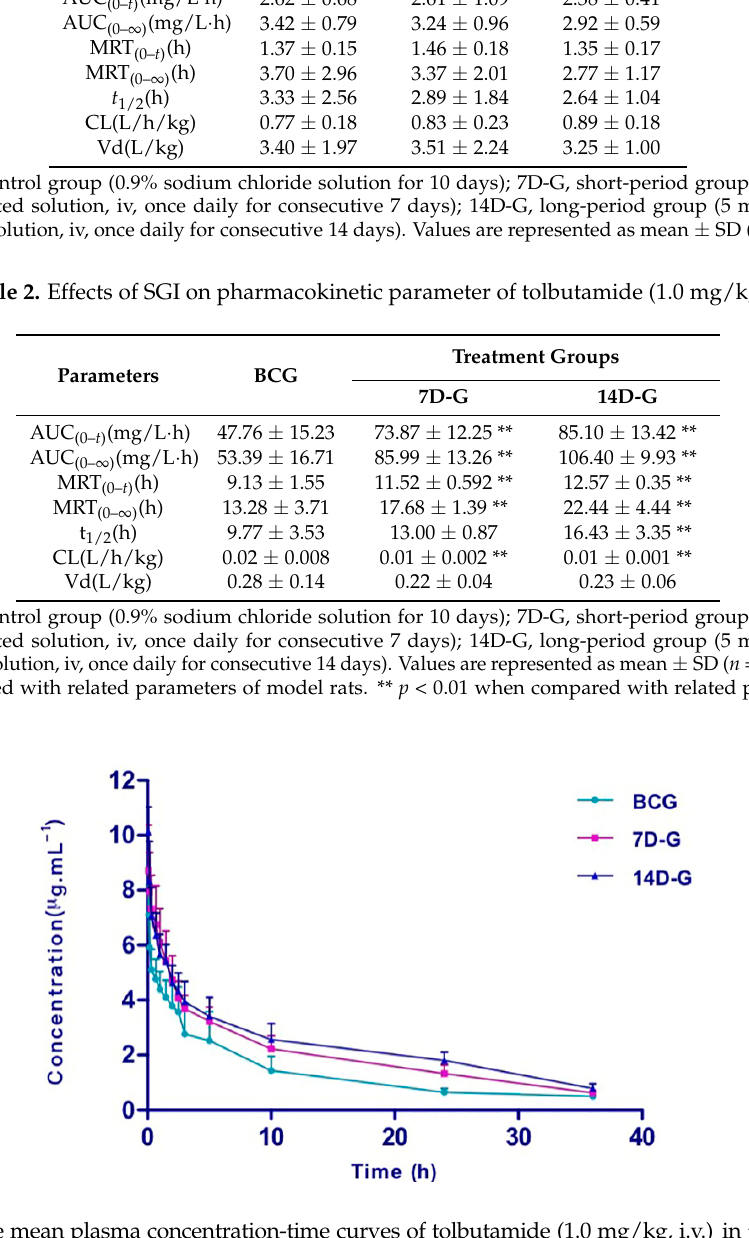
Figure 1. The mean plasma concentration-time curves of tolbutamide (1.0 mg/kg, i.v.) in the different groups ( n = 6). BCG, blank control group (0.9% sodium chloride solution for 10 days); 7D-G, short-period group (5 mL/kg of SGI concentrated solution, i.v., once daily for consecutive 7 days); 14D-G, long-period group (5 mL/kg of SGI concentrated solution, i.v., once daily for consecutive 14 days). Error bars represent SD.